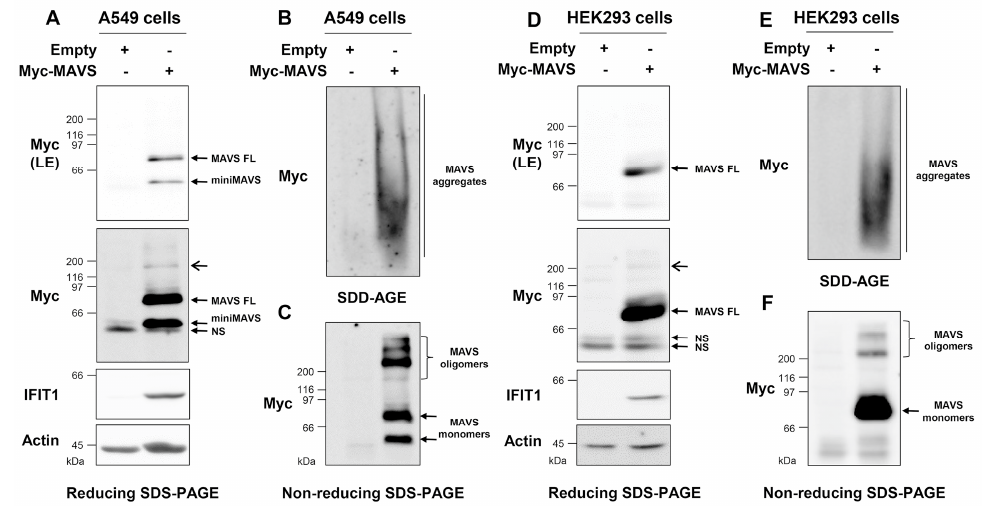
Figure 3. Detection of the aggregation and oligomerization states of ectopically expressed MAVS. A549 ( A – C ) and HEK293 ( D – F ) cells were transfected with a plasmid encoding for Myc-tagged MAVS (Myc-MAVS) or an empty vector. Cells were harvested, lysed, and WCEs were immediately subjected to reducing SDS-PAGE ( A , D ); SDD-AGE ( B , E ) or non-reducing SDS-PAGE ( C , F ); Proteins were detected by immunoblot using anti-actin, anti-Myc, or anti-IFIT1 antibodies. In ( A , D ), in addition to the exposure of the anti-Myc immunoblot corresponding to the exposure of panel ( C , F ), respectively, a lower exposure (LE) is shown for appropriate appreciation of miniMAVS. Open arrows indicate reducing-resistant forms of MAVS migrating at a MW higher than the monomers. NS: